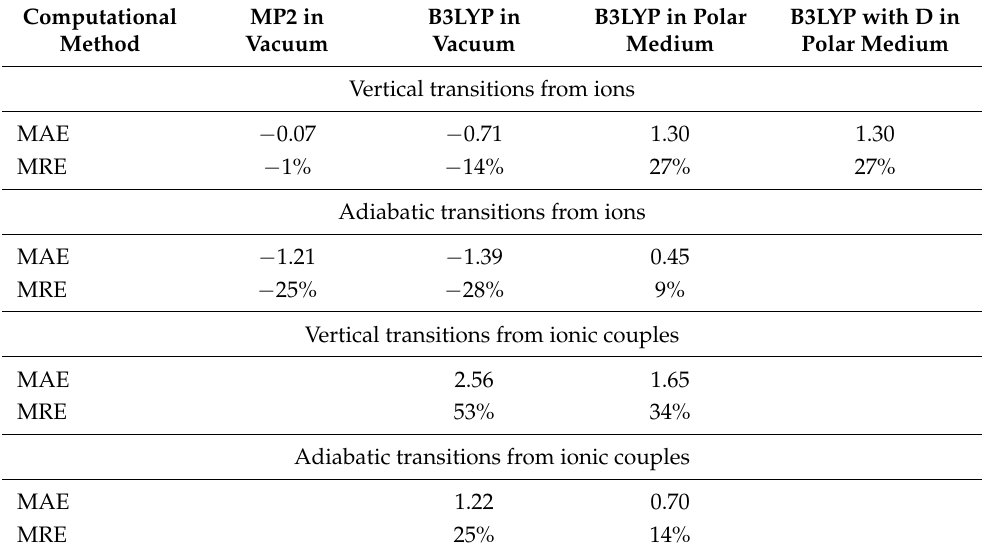
Table 10. MAE/V and MRE/% calculated for the eleven different computational/thermodynamic models